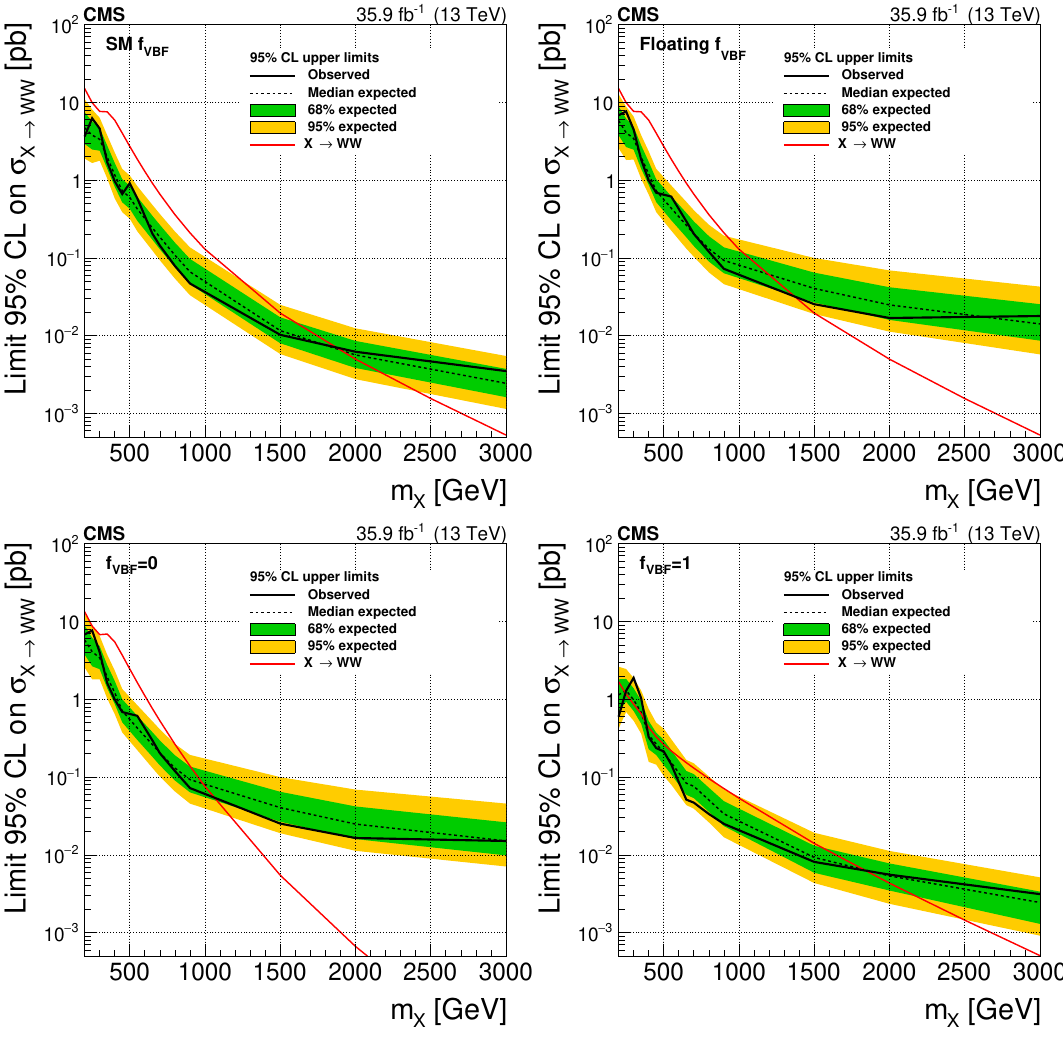
Figure 6 . Expected and observed exclusion limits at 95% CL on the X cross section times branching fraction to WW for a number of f hypotheses. For the SM f (upper left) and (cid:13)oating f VBF VBF VBF (upper right) cases the red line represents the sum of the SM cross sections for ggF and VBF production, while for the f = 0 (lower left) and the f = 1 (lower right) cases it represents VBF VBF the ggF and VBF production cross sections, respectively. The black dotted line corresponds to the central expected value while the yellow and green bands represent the 68 and 95% CL uncertainties,